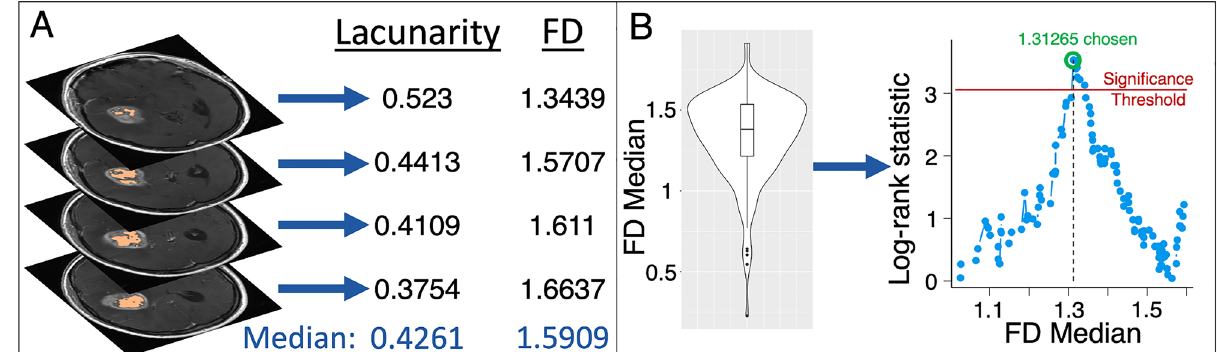
Figure 1. Computing lacunarity and fractal dimension (FD) and testing the statistical significance of these against patient survival data. ( A ) As an example, lacunarity and FD are computed on each slice of T1Gd necrosis segmentations. The median of these values is stored, giving one value of lacunarity and FD for each patient. We do the same for T1Gd enhancement with necrosis, and T2/FLAIR edematous regions. ( B ) Individual median values are collated into a cohort analysis. Each median value that does not split the cohort into groups of less than 10% of the cohort size is then tested as a cutoff to distinguish either overall survival or progression free survival. A log-rank test provides a significance value for each potential cutoff and a log-rank statistic is calculated alongside a separate significance threshold that accounts for multiple comparisons. The maximal log- rank statistic is chosen as this maximally distinguishes the two groups. This is carried out for lacunarity and FD, across necrosis, enhancement with necrosis, and edema